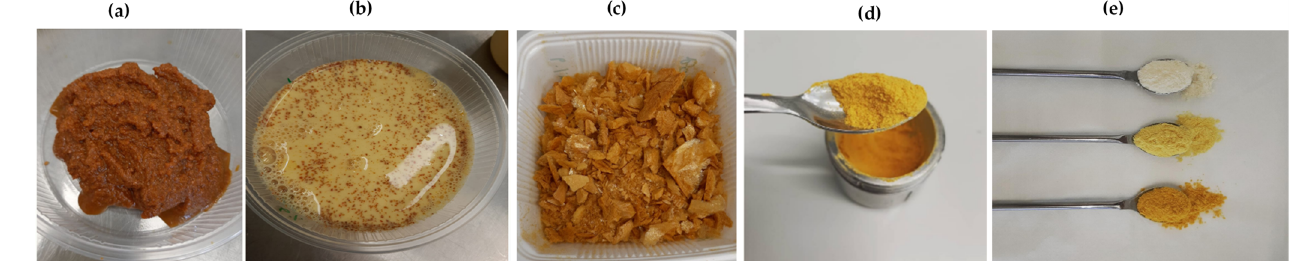
Figure 1. The preparation of homogeneous turmeric-fortified milk samples: ( a ) fresh turmeric paste, ( b ) 6% turmeric-fortified whole milk, ( c ) freeze-dried 6% turmeric-fortified whole milk, and ( d ) milled freeze-dried 6% turmeric-fortified whole milk ( e ) from left to right, 0%, 2%, and 6% milled freeze-dried turmeric-fortified whole milk samples.